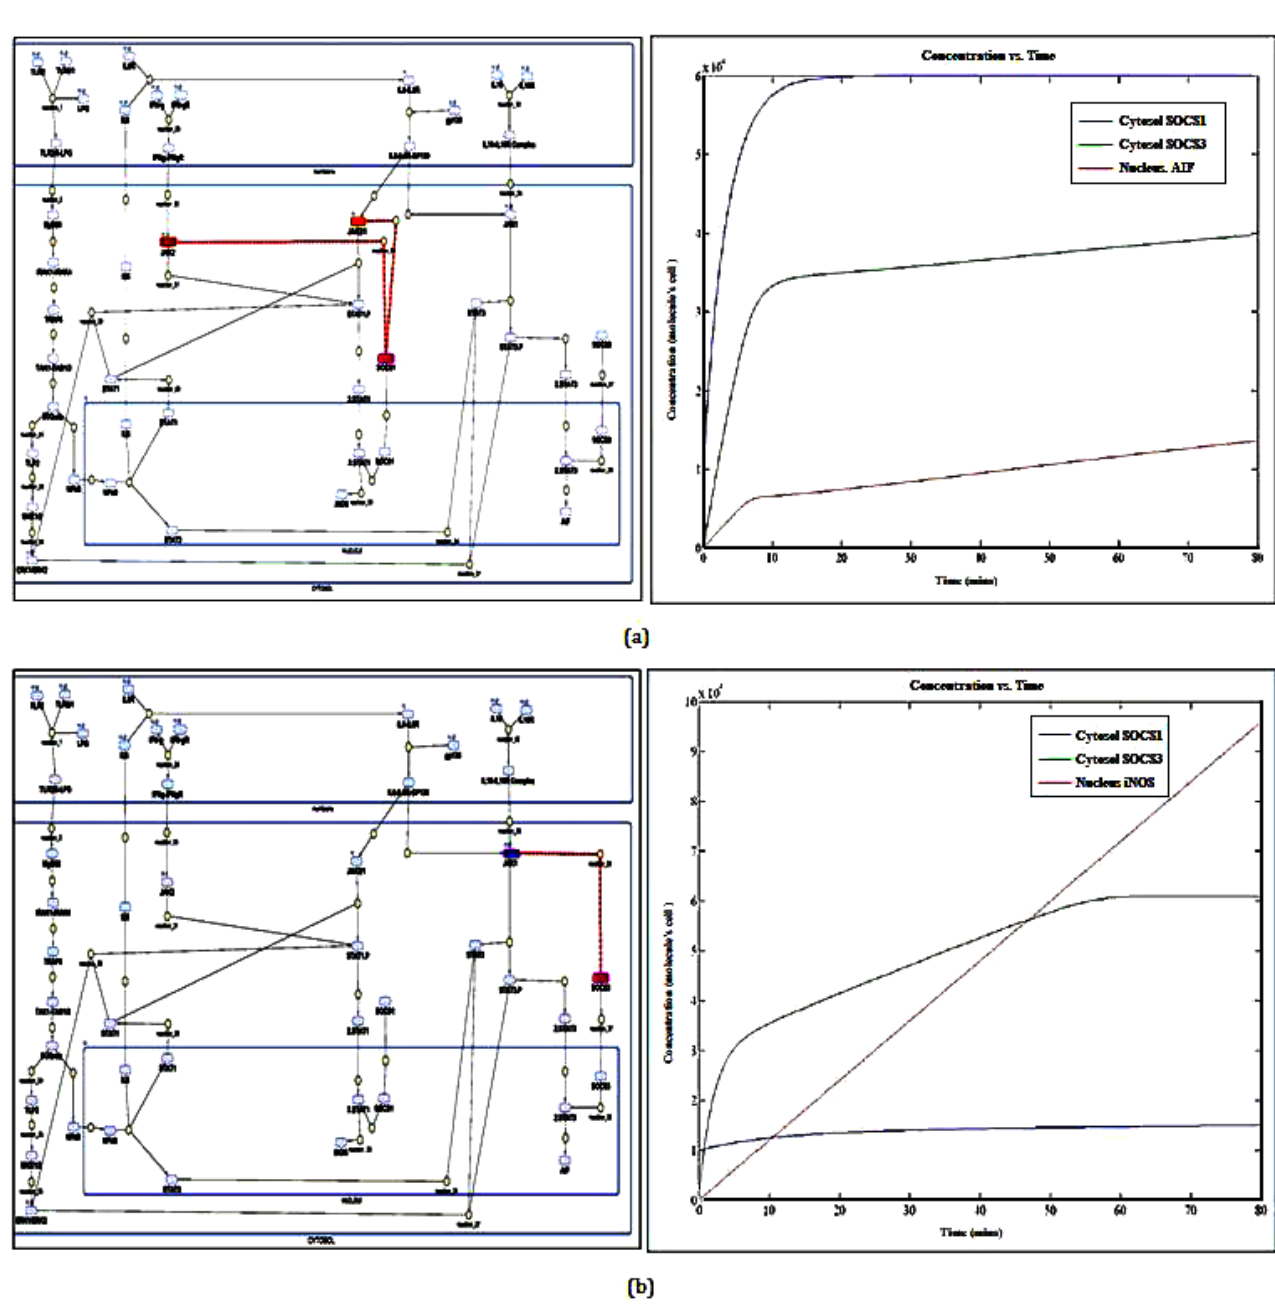
Figure 3. Refinement of TLR2-TLR6 and IL6 signaling pathway: ( a ) Mathematical model of M2 phenotype representing higher production of Anti-inflammatory factors (AIF) and SOCS1, ( b ) Mathematical model of M1 phenotype depicting higher production of iNOS and SOCS3at the end of 80 min simulation.